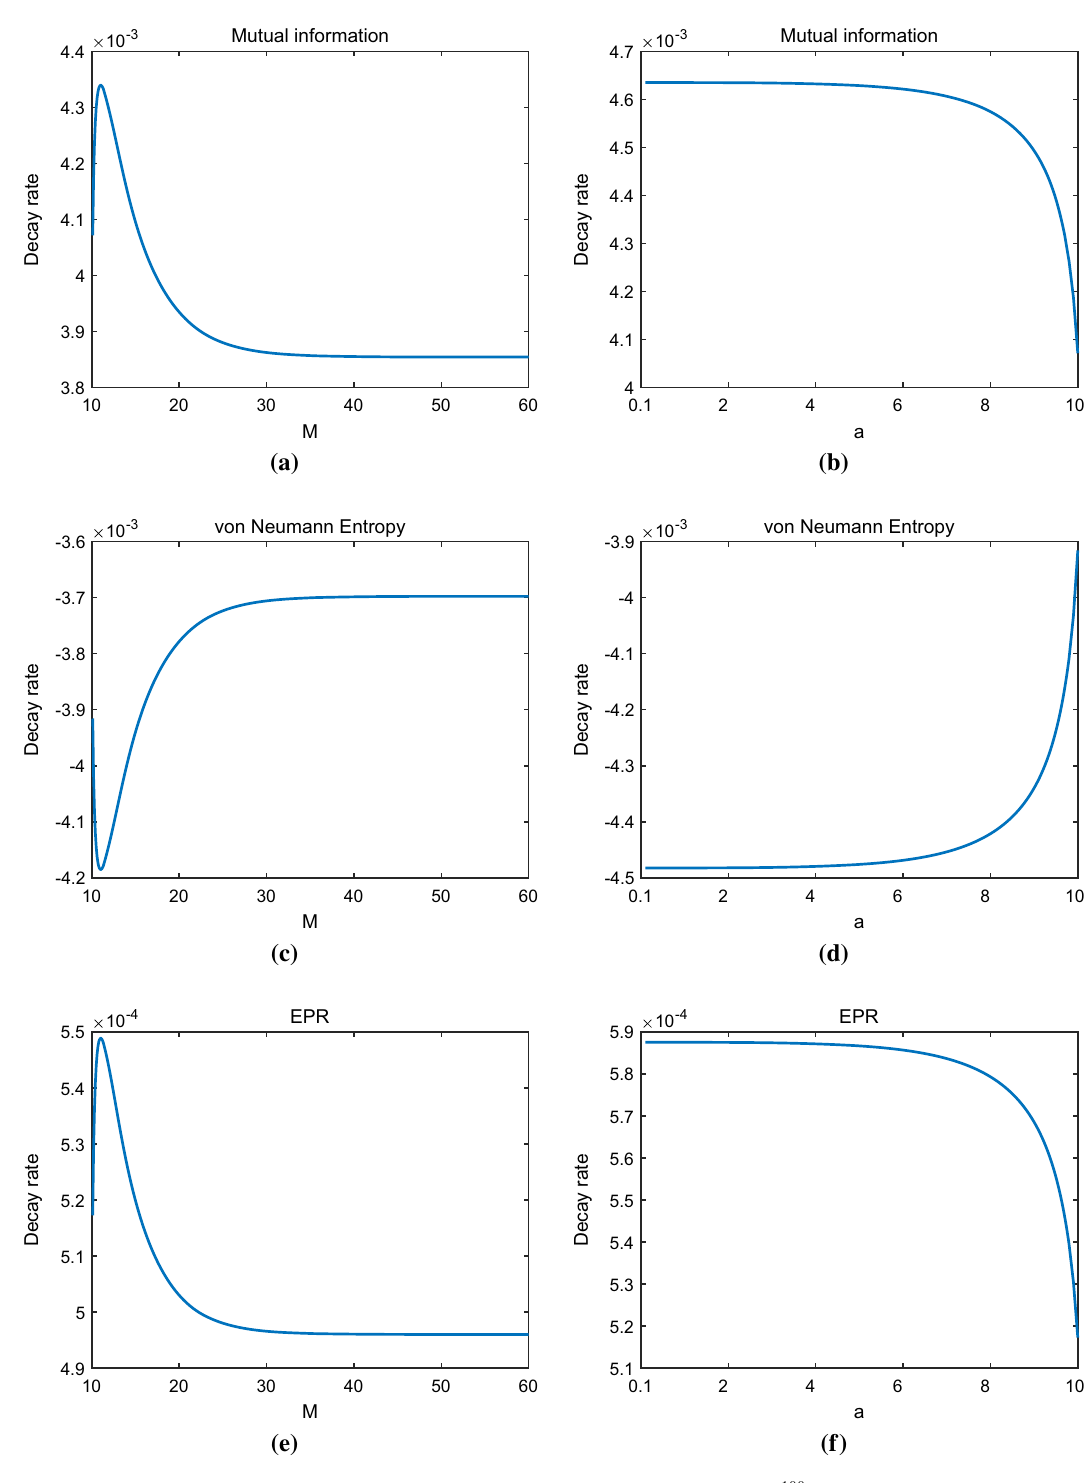
Fig. 10 The decay rates of the quantum correlations with respect to the mass when a = 10, t = 100 μ when m = 10, t = 100 μ . Other parameters are the same as those in Fig. 2